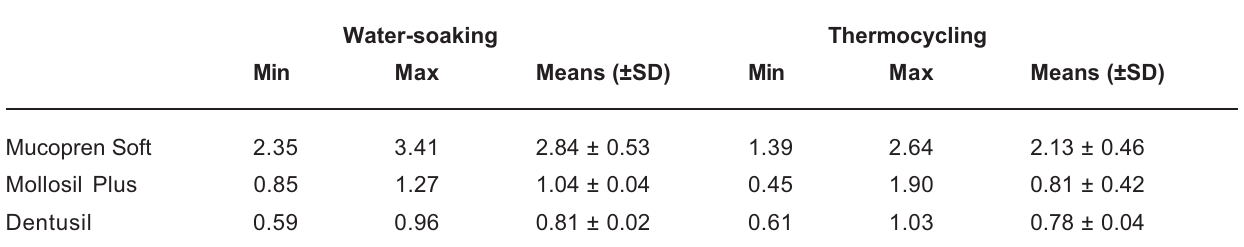
n = 10 specimens per experimental condition. TABLE 3- Shear bond strength (MPa) means (±standard deviation) for the water-soaked and thermocycled groups (N=60)